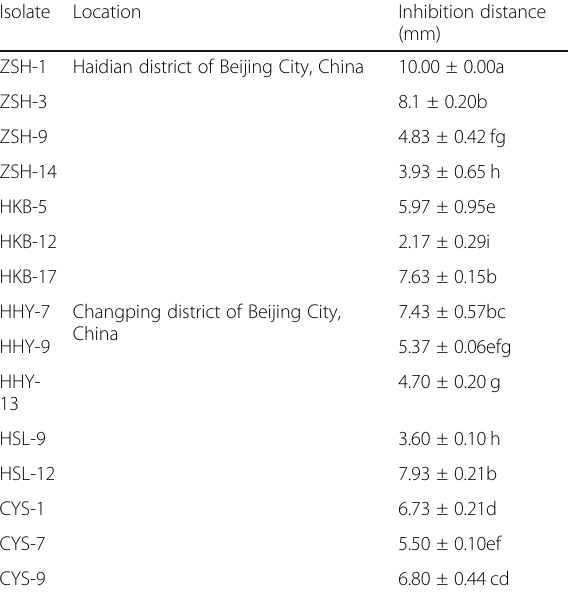
Table 2 Culture conditions and physiology-biochemical characteristics of strain